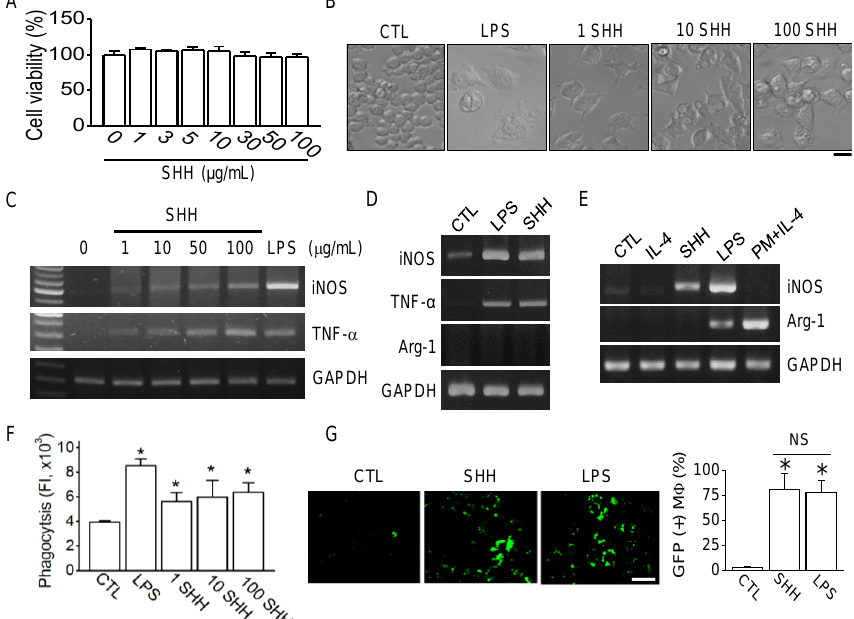
Figure 1. Sea hare hydrolysate-induced polarization to M1 of RAW264.7 cells. ( A ) E ff ect of sea hare hydrolysate (SHH) on cell viability. Di ff erent concentrations of SHH were used to treat RAW264.7 cells for 24 h. Each bar is the mean ± standard deviation (SD) obtained from five independent experiments ( n = 5). ( B ) Morphological changes in RAW264.7 cells activated by SHH treatment. Numbers (1, 10, and 100) above the figures represent the concentration ( µ g / mL). LPS (1 µ g / mL) was used as a positive control. Scale bar, 15 µ m. ( C ) SHH-induced increase in iNOS and TNF- α expression. Glyceraldehyde-3-Phosphate Dehydrogenase (GAPDH) was used as a loading control to compare the mRNA expression level among treatments. ( D ) No expression of Arg-1, a marker of M2, in RAW264.7 cells. LPS (1 µ g / mL) was used as a positive control for induction of iNOS and TNF- α expression. ( E ) No e ff ect of IL-4 and SHH on Arg-1 expression in RAW264.7 cells. The Arg-1 was expressed in the IL-4-treated mouse peritoneal macrophages. ( F ) Increase in the phagocytic ability of RAW264.7 cells by SHH treatment. Cells cultured in 96-well black plates were treated with LPS or SHH and loaded with latex bead rabbit IgG FITC complex. The degree of phagocytosis was analyzed using a fluorescence microplate reader. Each bar is the mean ± SD obtained from nine independent experiments ( n = 9). * p < 0.05 compared to control (CTL). FI represents fluorescence intensity. ( G ) RAW264.7 cells phagocytized A549 lung cancer cells. The cancer cells were transfected with green fluorescent protein (GFP) and co-cultured with RAW264.7 cells for 24 h under SHH treatment. Strong green fluorescence instead of dots shows A549 cells transfected with GFP. The bar graph shows the percentages of GFP positive cells (RAW264.7 cells that phagocytized A549 cells). Each bar is the mean ± SD obtained from four independent experiments ( n = 4). LPS treatment was used as a positive control. NS, not significant. Scale bar, 30 µ m. * p < 0.05 compared to control